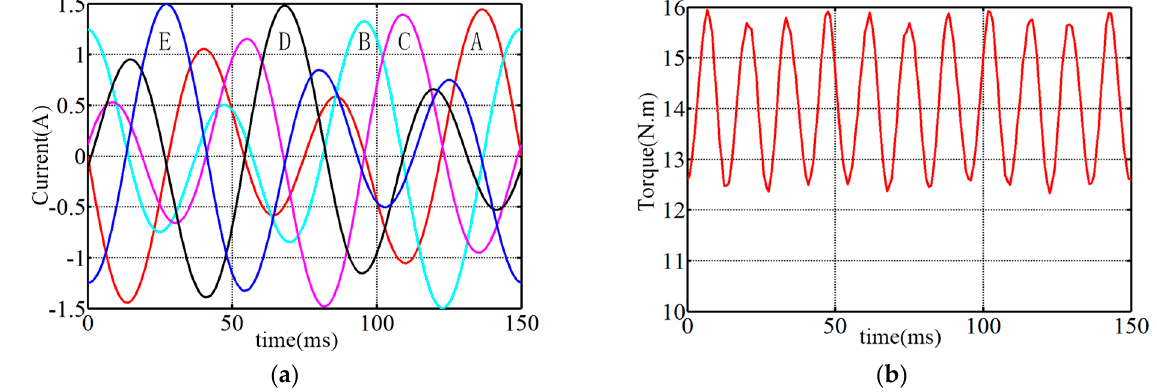
Figure 12. The current and torque simulation of series − connected THI − FPMSM with i cmp : five − phase current; ( b ) torque.